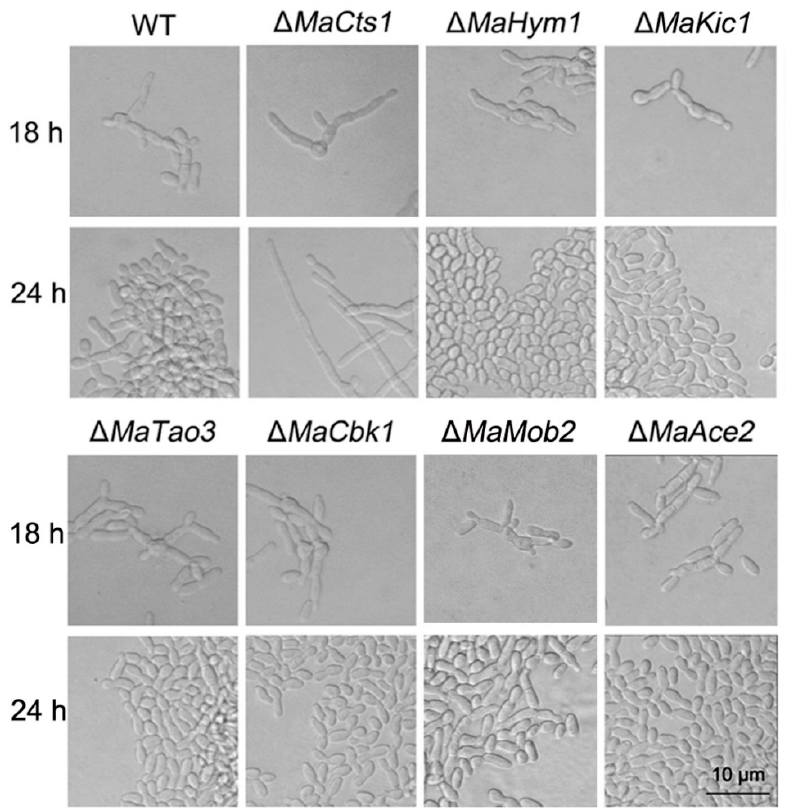
Figure 5. The key components of the MOR/RAM pathway are not related with the shift in conidiation pattern in M. acridum . The conidiation pattern of WT and disrupted mutants at 18 h and 24 h after incubation on SYA medium.